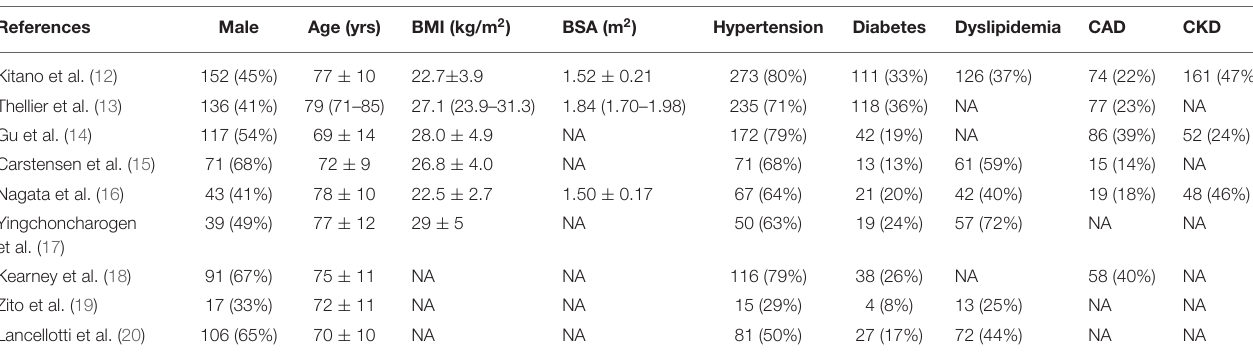
TABLE 2 | Clinical characteristics of